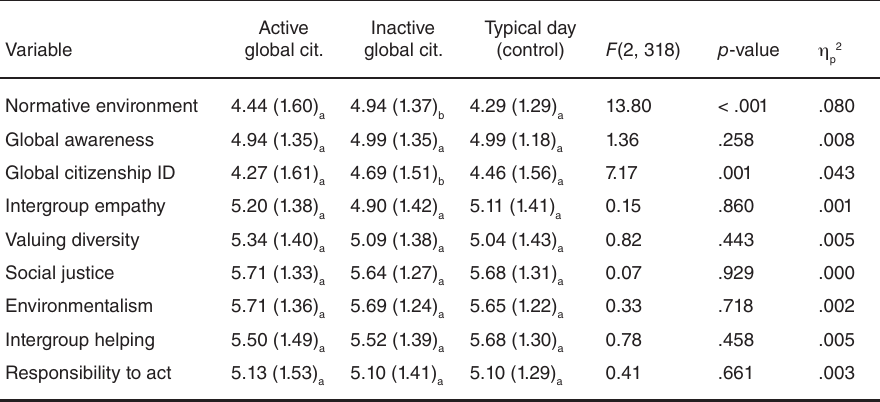
Table 3: Means (standard deviation) by condition Variable